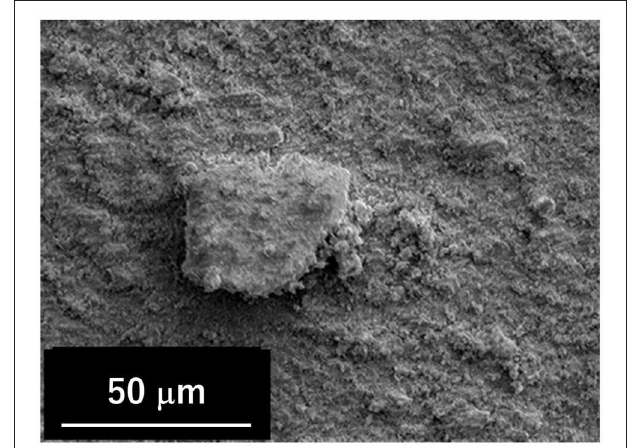
FIGURE 2 | Scanning electron microscope image of rosin